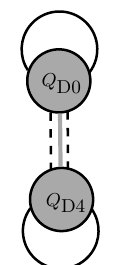
Figure 1 . Quiver quantum mechanics associated to the D0-D4-F1 brane system. The solid black lines represent (4,4) adjoint hypermultiplets, the grey line a (0,4) hypermultiplet and the dashed lines two (0 , 2) Fermi multiplets. Circles represent N = (4 , 4) vector